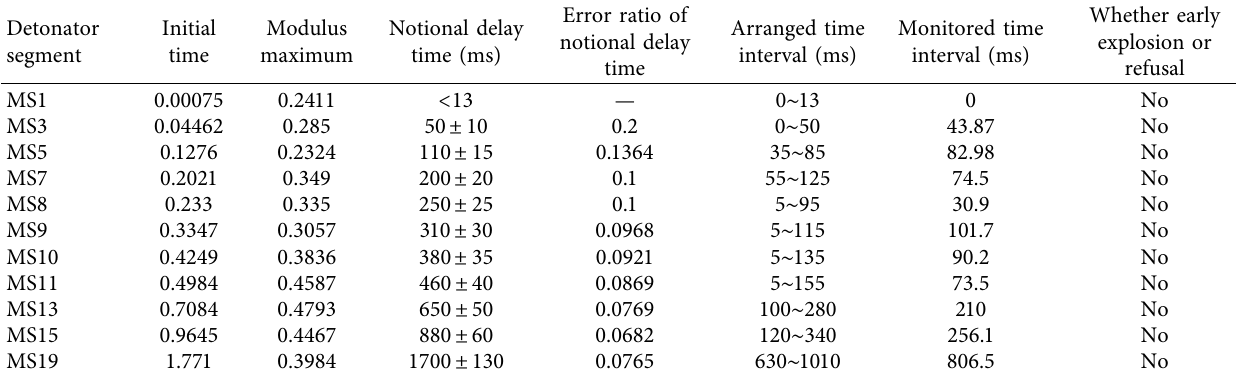
Table 3: Detonator deferment stages, deferral times, and actual differential